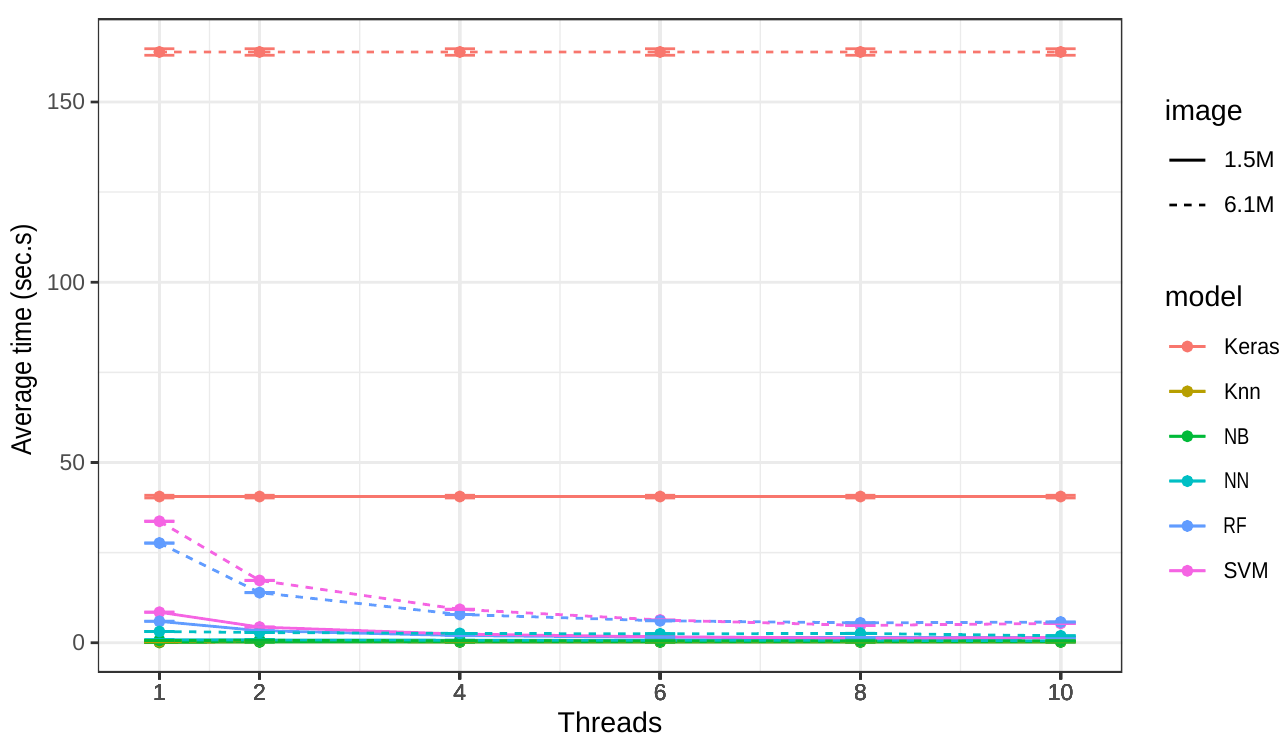
Figure 3. Classification time (in s) of each model used. Table 2. Average classification time (in s), based on number of threads (from 1 to 10) and image size (from 1.5 to 6.1